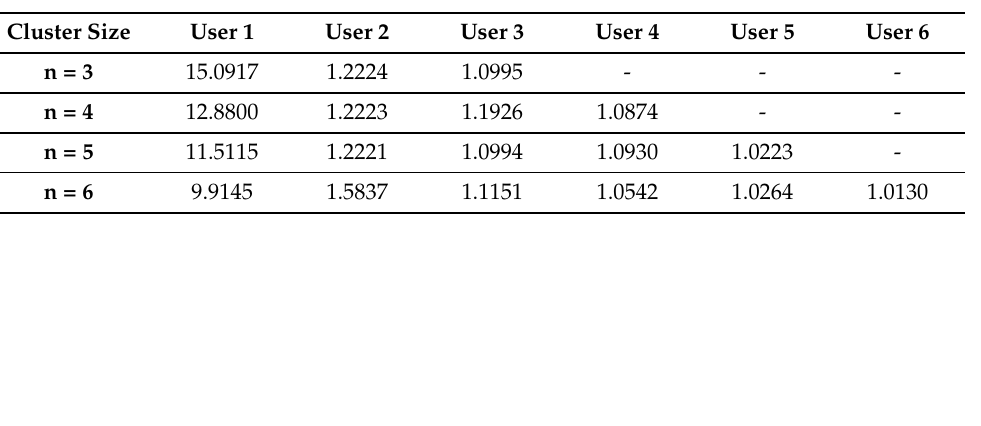
Table 6. Normalized IDRs’ Monte-Carlo simulation analysis in bits per sec per Hertz for Magic matrix-based power allocation [22] in downlink RIS NOMA